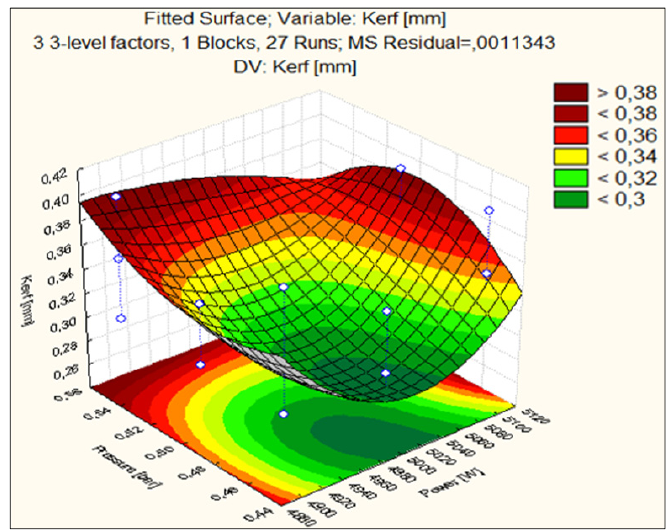
Figure 9. Prediction of the dependence of the cutting width on the laser power and the assist gas pressure.